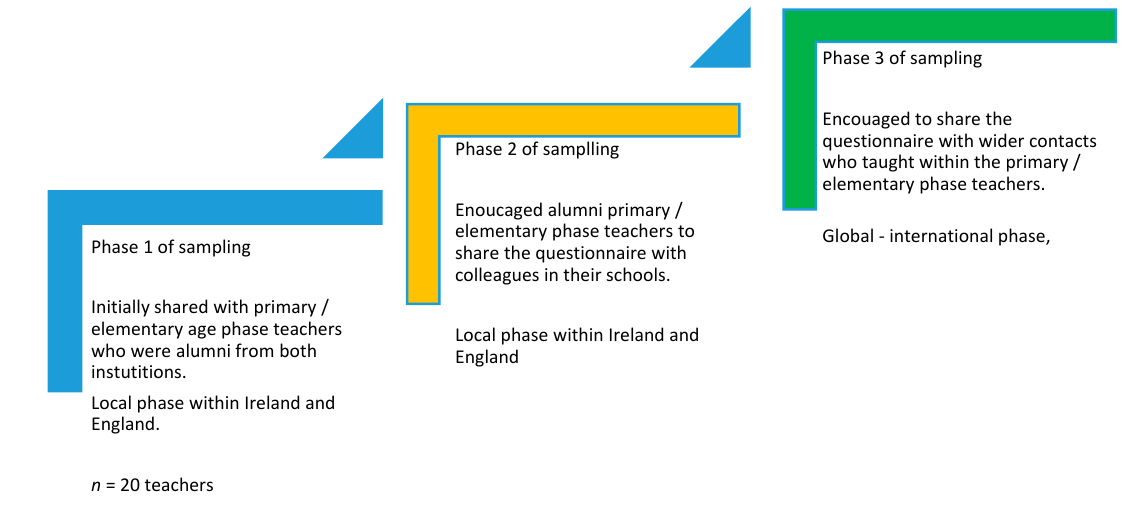
Figure 1. Snowball sampling technique.